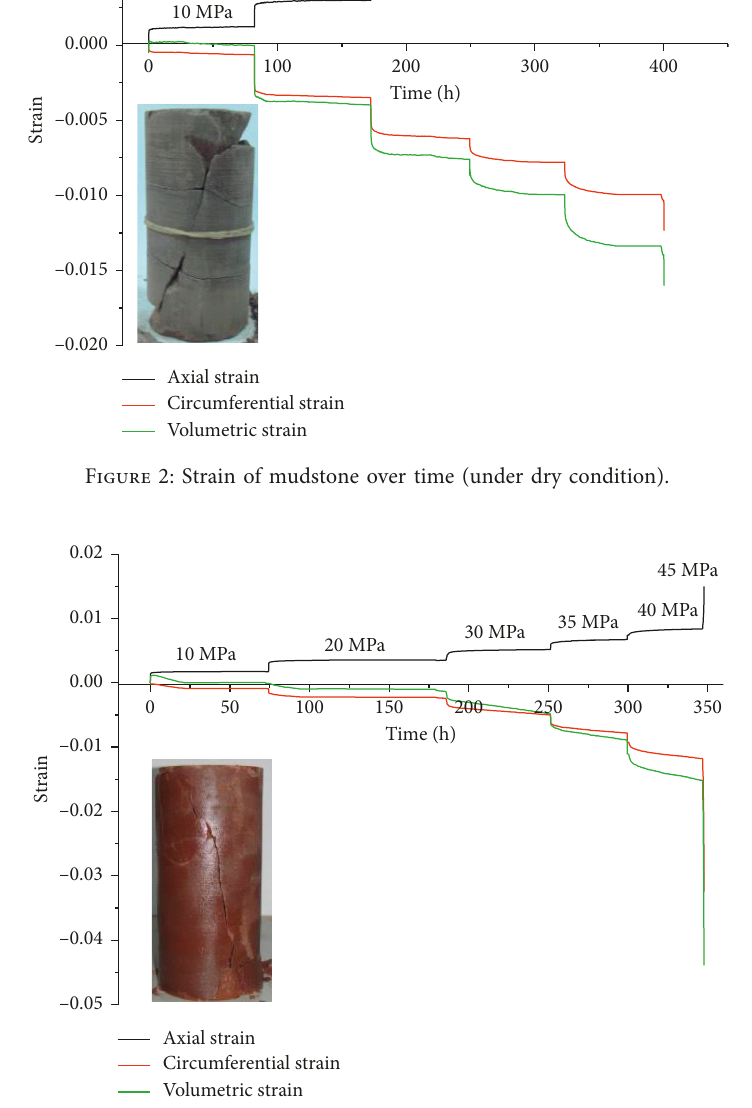
Figure 3: Strain of mudstone over time (under saturated